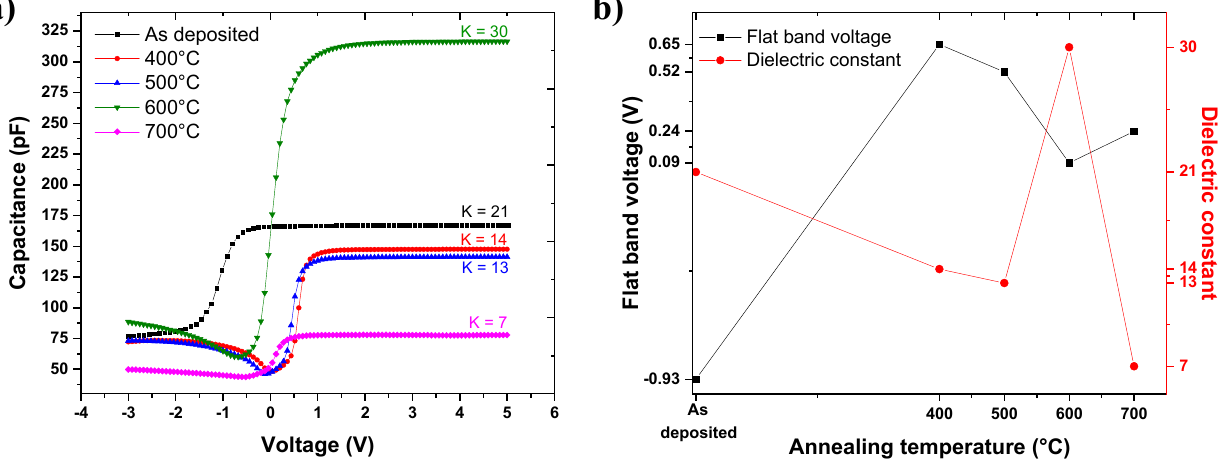
Figure 4. ( a ) C–V characteristics curves at 1 MHz of Hg-LMO-Si MOS structures obtained for the LMO film as deposited and after annealing with the values of the relative dielectric constants K. ( b ) Flat band voltage V FB (black curve) and dielectric constant (red curve) in function of different annealing temperatures.